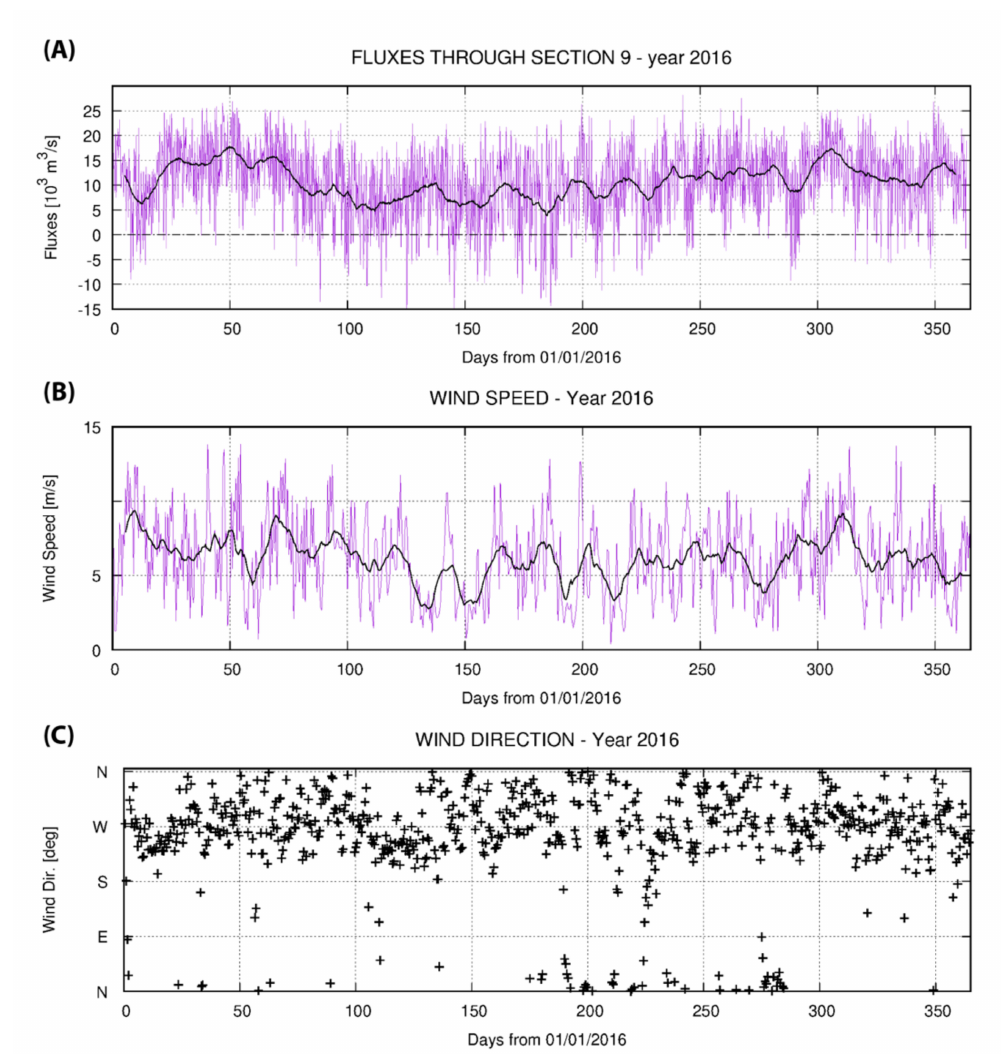
Figure A4. Fluxes through Section S9ab during the whole of 2016 ( A ), three-hour of data (colored line) and ten-day averages (black continuous line). Positive values indicate an eastward flow, while negatives indicate a westward one. Wind speed ( B ) and directions ( C ) at Ushuaia Bay are obtained from the adopted meteorological forcing dataset for the entire year of 2016. In ( B ), colored line indicates the original dataset at semidiurnal frequency, and the black line indicates the ten-day- averaged